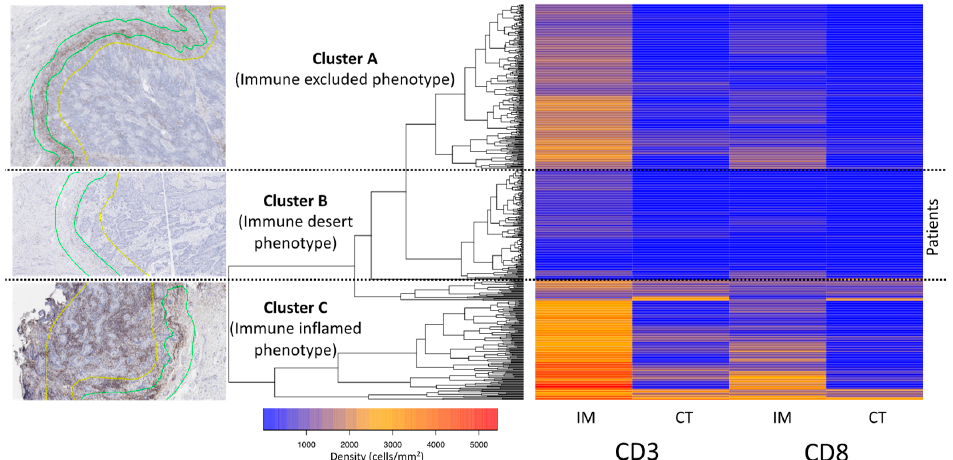
Figure 3. Unsupervised hierarchical cluster analysis of vulvar cancer samples. The two-way (T-cell